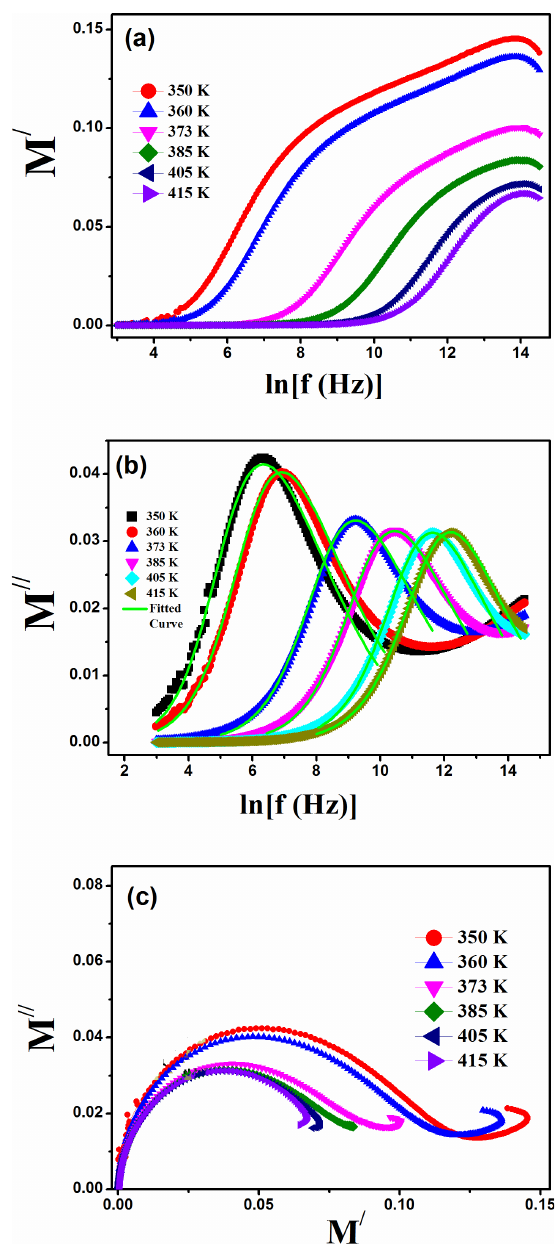
Figure 8: (a) Real electric modulus ( M ′ ) spectra of the sample, (b) electric modulus ( M ′′ ) spectra of the sample, (c) Complex electric modulus spectra in the electric modulus